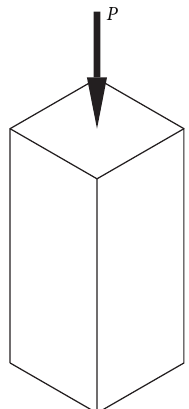
Figure 1: Concentrically loaded columns.